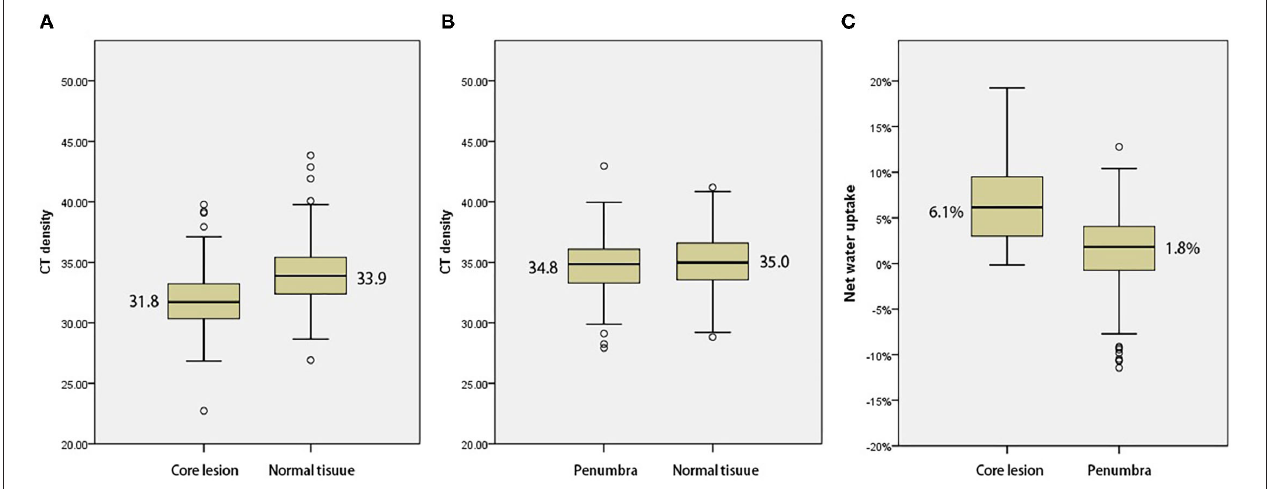
FIGURE 2 | (A) Comparison with mean density of the ischemic core and normal tissue. (B) Comparison with mean density of penumbra and normal tissue. (C) Comparison of net water uptake (NWU) with ischemic core and penumbra.